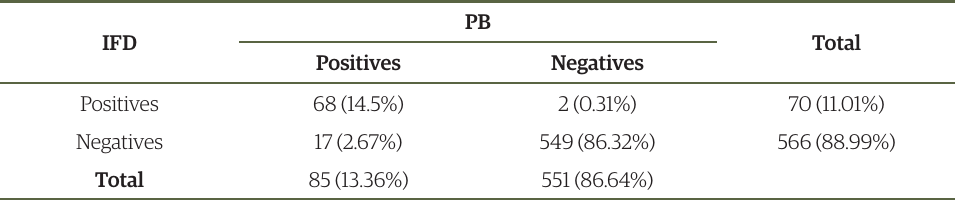
Table 1. Comparison between the results of the fluorescent antibody test (IFD) and mouse inoculation test (PB) of equine and bovine brains SDZ from 2001 to 2015.